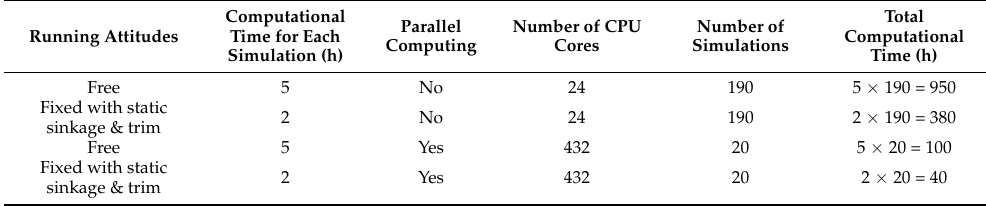
Table 7. Considerations on the computational time for hull form